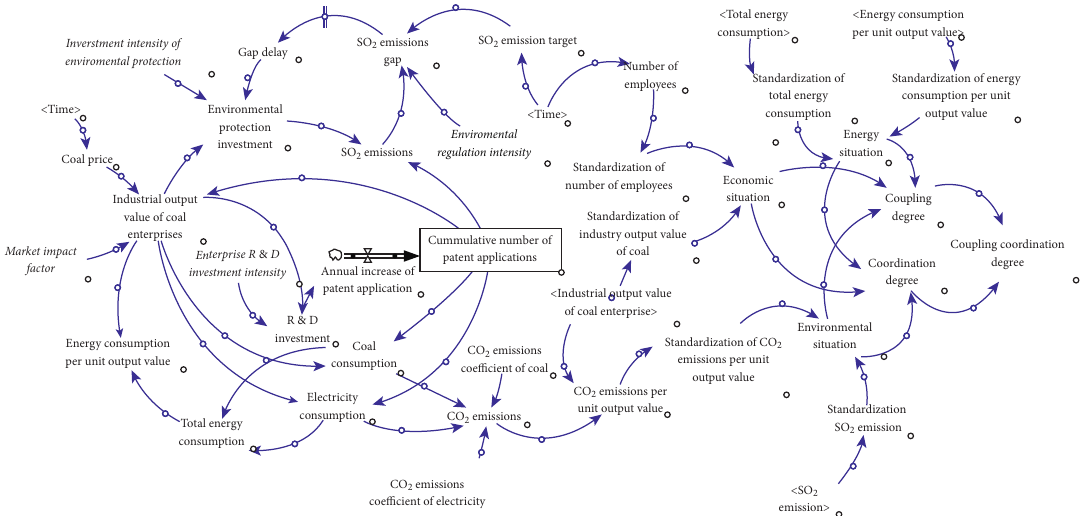
Figure 3: Stock flow chart of the green low-carbon development system of coal